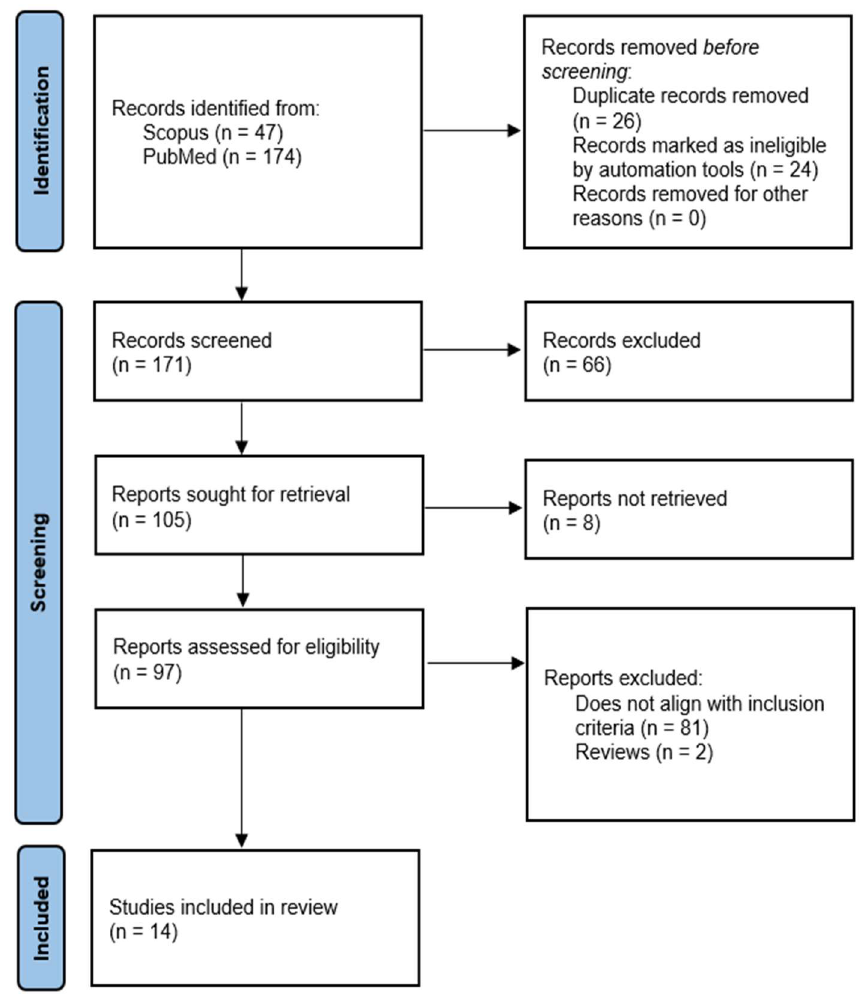
Figure 1. Flowchart for study selection in accordance with Preferred Reporting Items for Systematic Reviews and Meta-Analyses (PRISMA) guidelines.